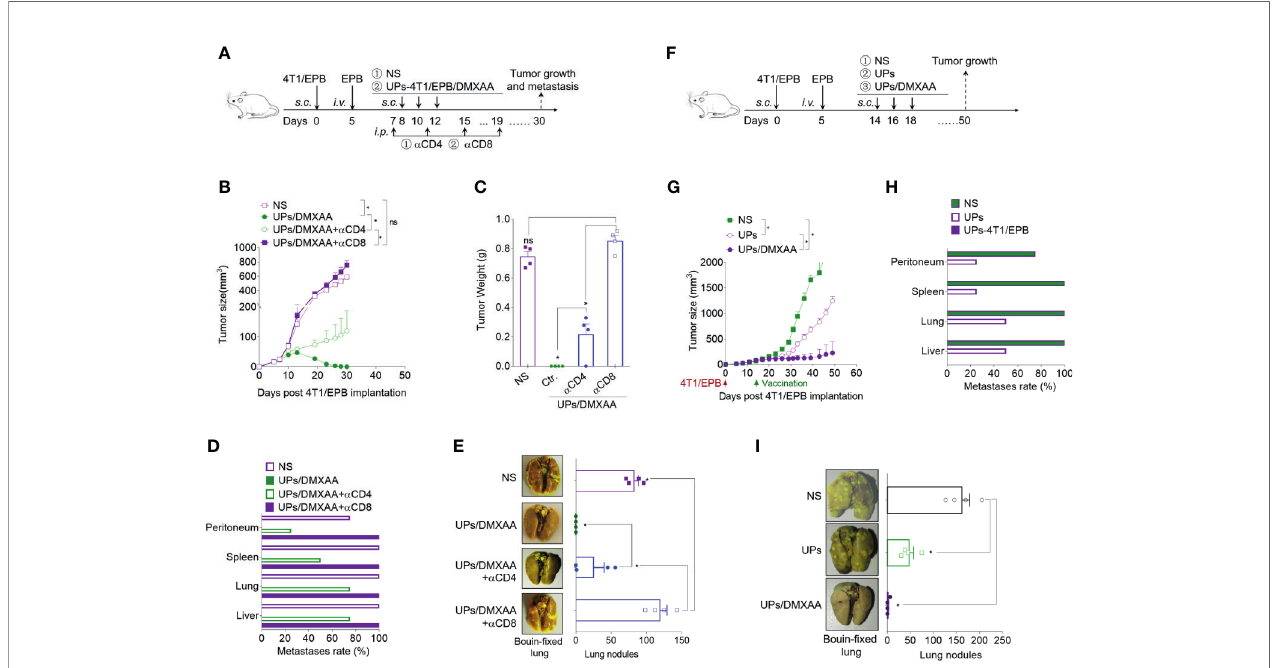
FIGURE 5 | The combination of ubiquitinated proteins (UPs)-4T1/epirubicin (EPB) nanovaccine with chemotherapy and stimulator of interferon genes (STING) agonists exhibited strong anti-tumor effects in larger breast cancer. (A) Immunization protocol for UPs-4T1/EPB nanovaccine combined with STING agonists in CD4 + T cell-depleted or CD8 + T cell-depleted mice ( n = 4 to 6 per group). (B – E) The tumor growth (B) , survival (C) and metastasis rate (D) were monitored. Representative Bouin ’ s- fi xed lungs and the number of lung metastatic nodules in tumor-bearing mice (E) . (F) Immunization protocol for UPs-4T1/EPB nanovaccine combined with chemotherapy and STING agonists in larger breast cancer ( n = 4 to 6 per group). (G – I) The tumor growth (G) and metastasis rate (H) were monitored. Representative Bouin ’ s- fi xed lungs and the number of lung metastatic nodules in tumor-bearing mice (I) . P -values were determined by Mann – Whitney U -test. The results are representative of three independent experiments, and data were expressed as means ± SEM (* p < 0.05; ns, not signi fi